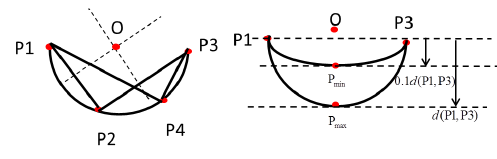
Figure 3. Parameters of the circle. P,